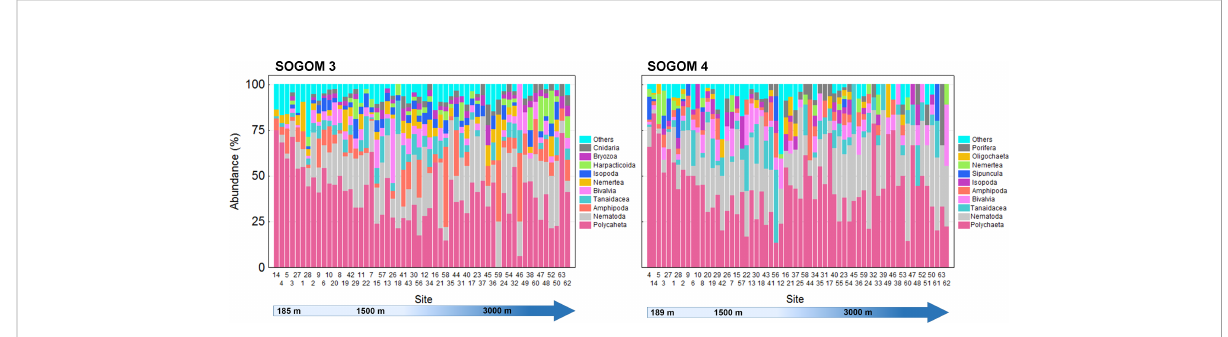
FIGURE 6 Relative abundance of the ten most abundant macrofauna taxa related to depth in SOGOM 3 and SOGOM